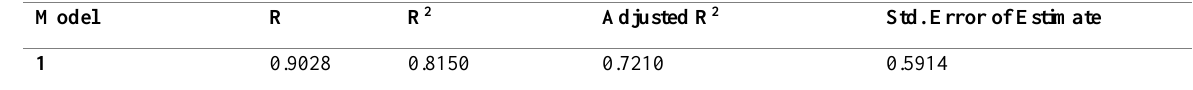
Table 10: Summary of the